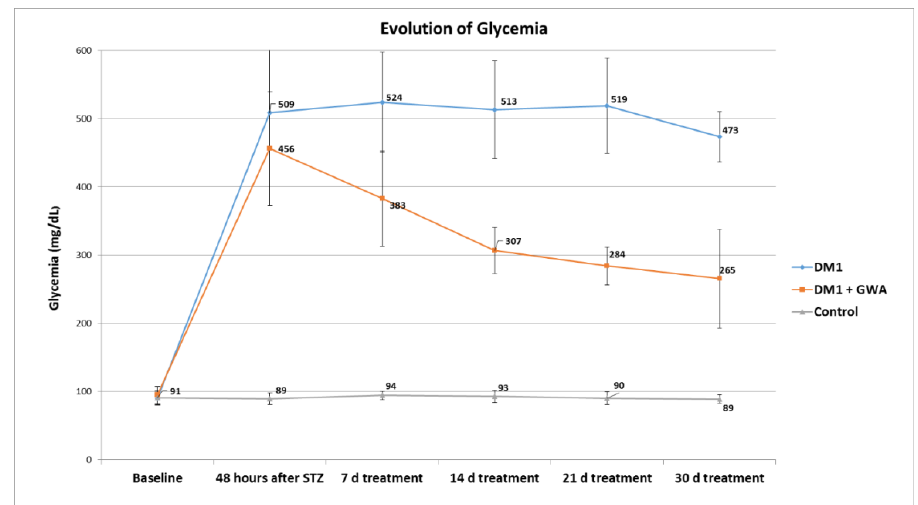
Figure 2. Blood glucose levels evolution during 30 days from Control, DM1 and DM1 + GWA groups. p < 0.01 between DM1 and DM1 + GWA groups.